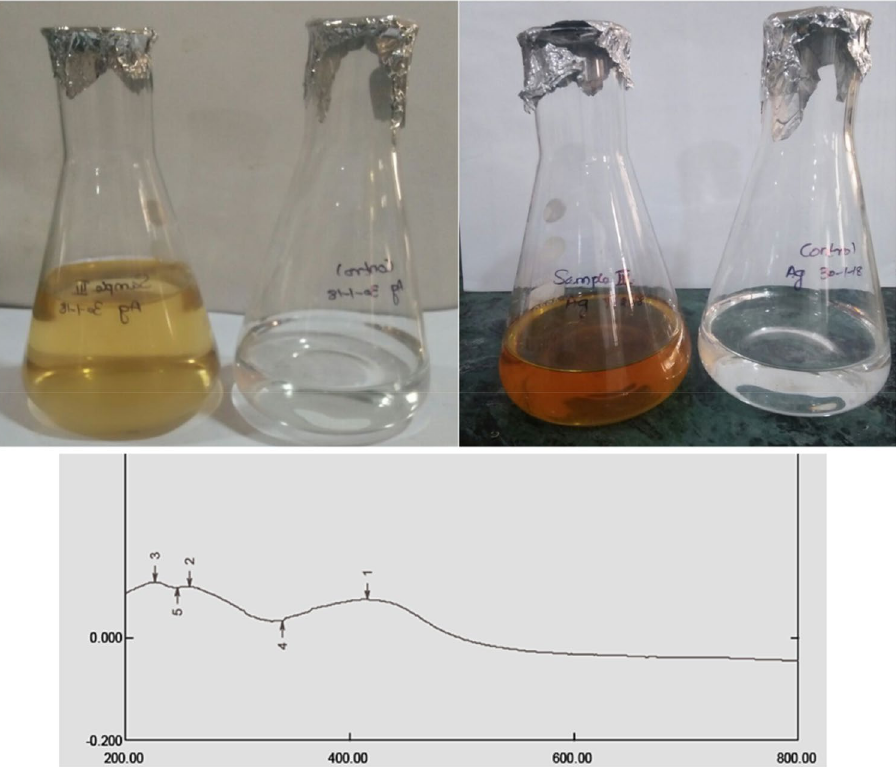
Figure 3. Biosynthesis of silver nanoparticles. ( a ) Before incubation. ( b ) After 48 h of Incubation and ( c ) UV– visible spectrophotometer of silver nanoparticles synthesized from extract of Ulva